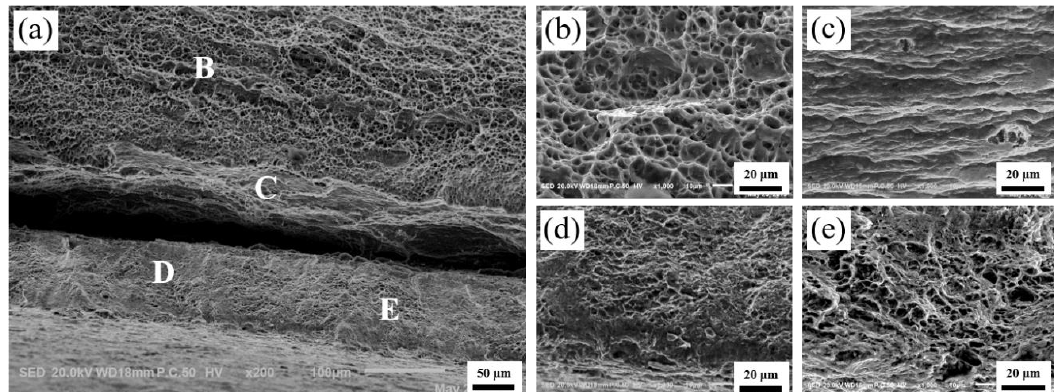
Figure 13. Fractography in 45° direction. ( a ) Macro-fractography, ( b ) HRF at position B in Figure 13a, ( c ) HRF at position C in Figure 13a, ( d ) HRF at position D in Figure 13a, ( e ) HRF at position E in Figure 13a.